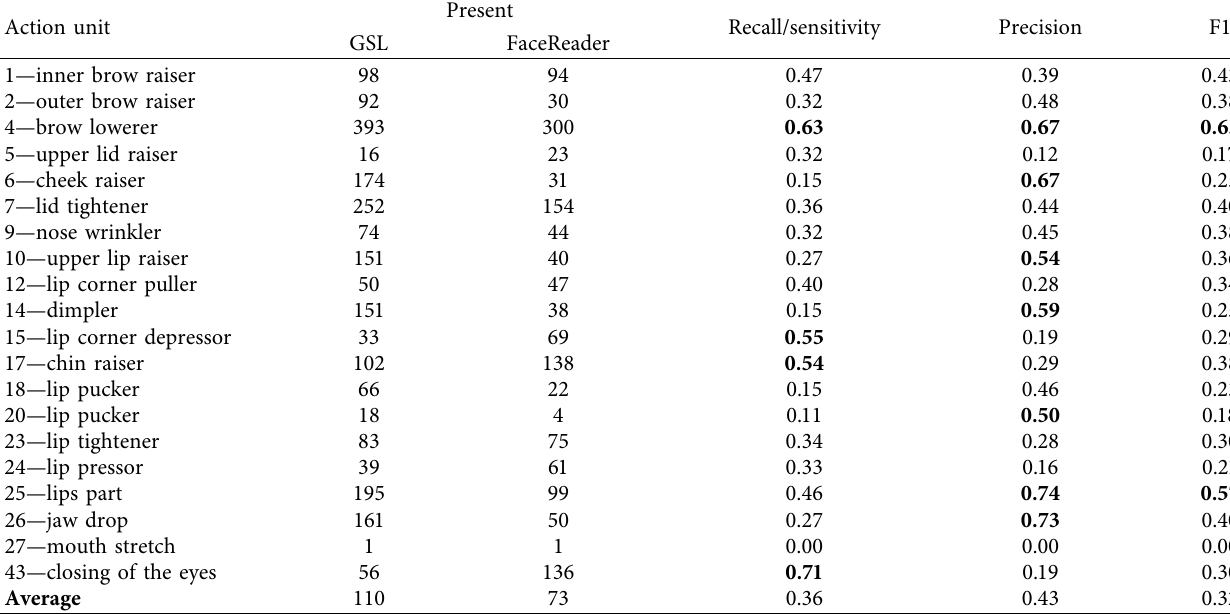
Table 1: Congruency indices between manual and automatic AU